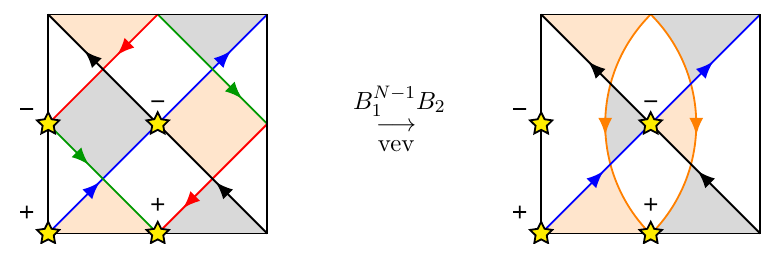
Figure 18. Effect of the Higgsing on the brane tiling for phase II